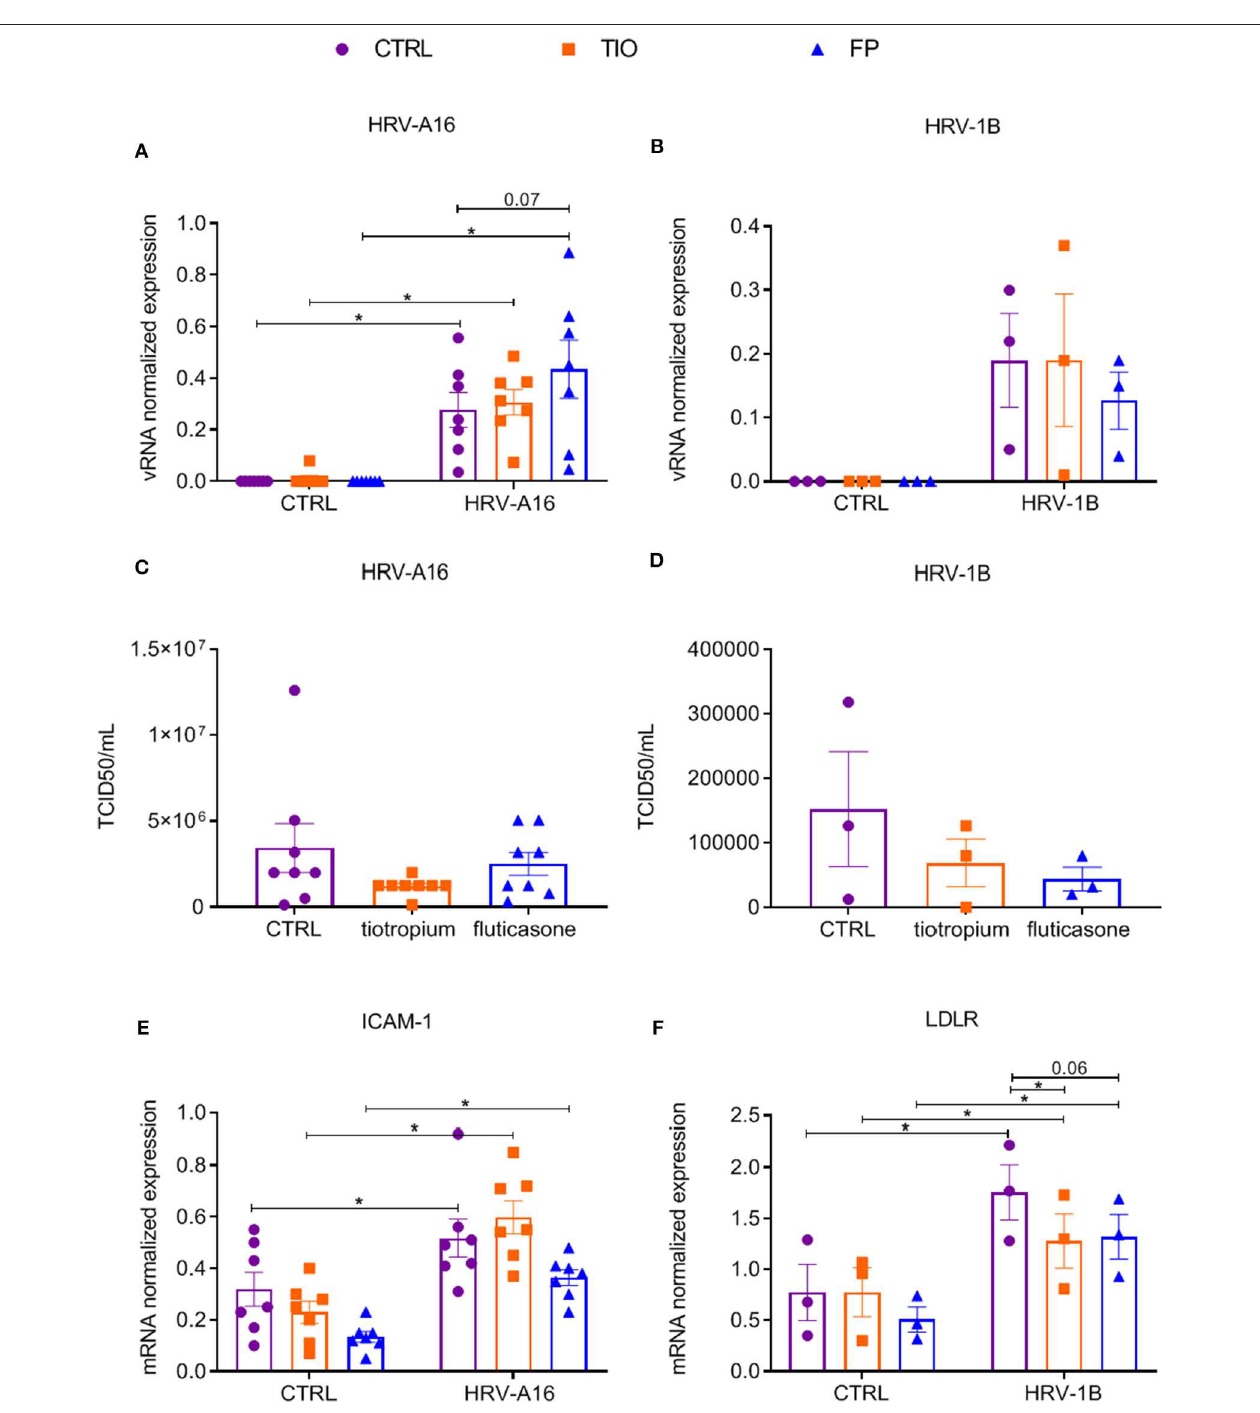
FIGURE 4 | Effects of tiotropium bromide and fluticasone propionate on viral infection in ALI-PBEC. ALI-PBEC were pre-treated with tiotropium or fluticasone and infected with HRV-A16 (MOI 5). Cells were harvested at 48h after infection. (A,B) The vRNA expression of HRV-A16 ( n = 7) and HRV-1B ( n = 3) together with (C,D) viral particles were measured by TCID50 assay ( n = 8 or 3). (E,F) Gene expression of ICAM-1 ( n = 7) and LDLR ( n = 3) were examined by qPCR. Data are shown as target gene expression normalized for RPL13A and ATP5B or TCID50/mL. Data are mean values ± SEM. n = 3, 7, and 8 independent donors. Analysis of differences was conducted by two-way ANOVA with a Tukey post-hoc test Significant differences are indicated by * P < 0.05 compared with control or HRV-A16 group.